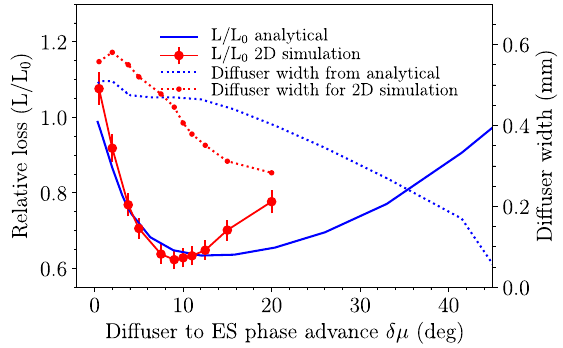
FIG. 17. 2D simulated and analytical relative total loss reduc- tion as a function of the phase advance between the diffuser and ES, for WRe diffuser length 5 mm.